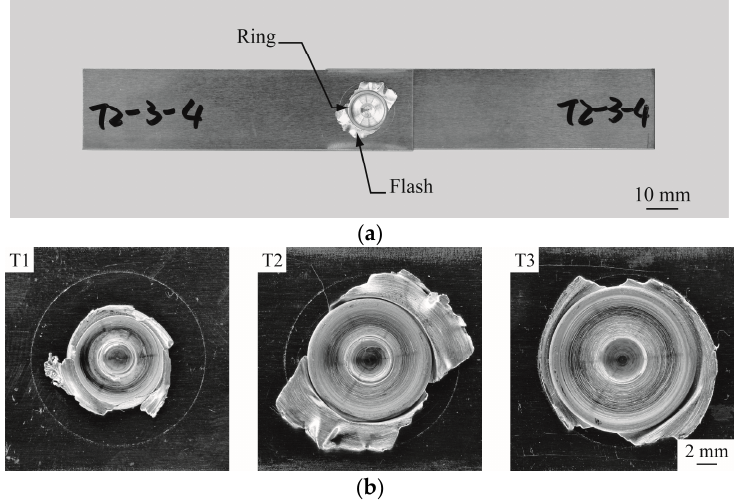
Figure 5. ( a ) A lap-shear specimen with a 6061-T6 FSSW made by T2 tool; ( b ) close-up top views of FSSWs made by T1, T2 and T3 tools, respectively.